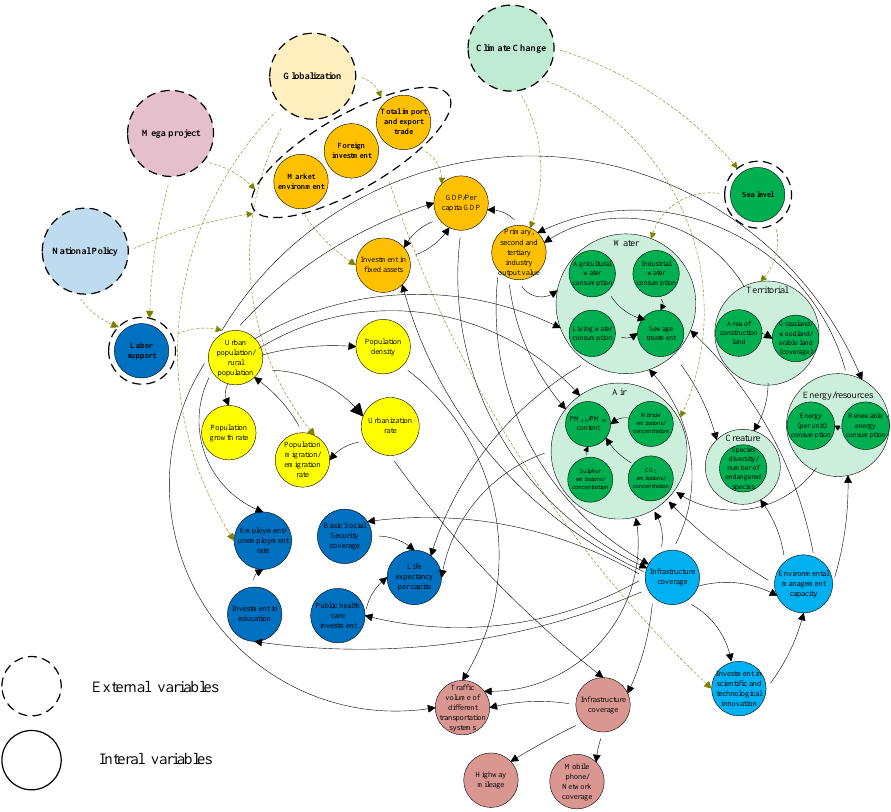
Figure 8. Stock and flow diagram of the Urbanization and eco-environment system in the BTH region.